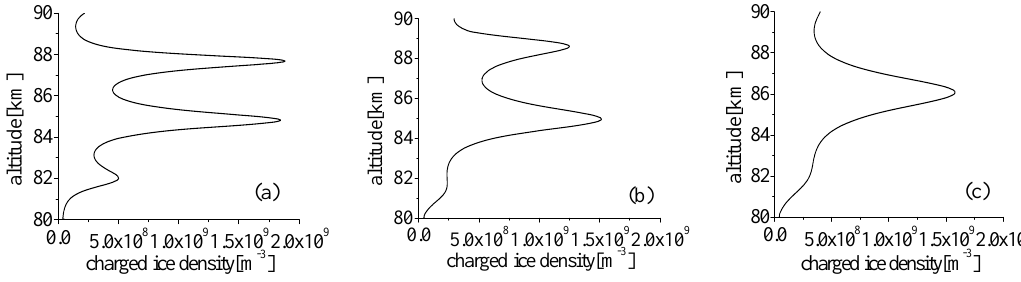
Fig. 2. The influence of vertical wavelength on the formation of ice particle layers, the wavelength λ = 3km, 4km, 5km, respectively. Fig. 2 The influence of vertical wavelength on the formation of ice particle layers, The wavelength λ =3km, 4km, 5km respectively. determine the initial distribution in our model calculation. gravity wavelength. Figure 2 shows the structure evolution of charged ice particle layers with different vertical gravity wavelength λ =3 km, 4 km, 5 km, respectively, and the other parameters are the same to Fig. 1. As a reference case, the model was run for an hour. For example, when the λ = 3 km, three layers can be produced (panel a), double-layers when λ = 4 km (panel b), and only one obvious single layer when λ = 5 km (panel